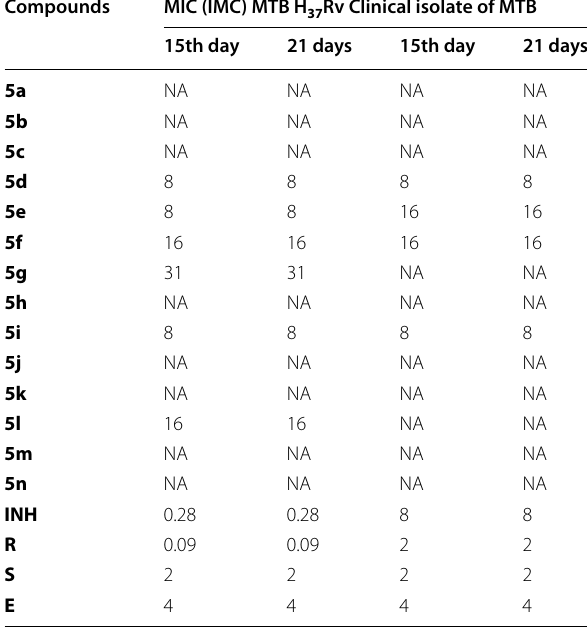
Controles used were first line drugs INH-isoniazid S Streptomycin, E Ethambutol, R Rifampicin, NA compound was not active TB isolates